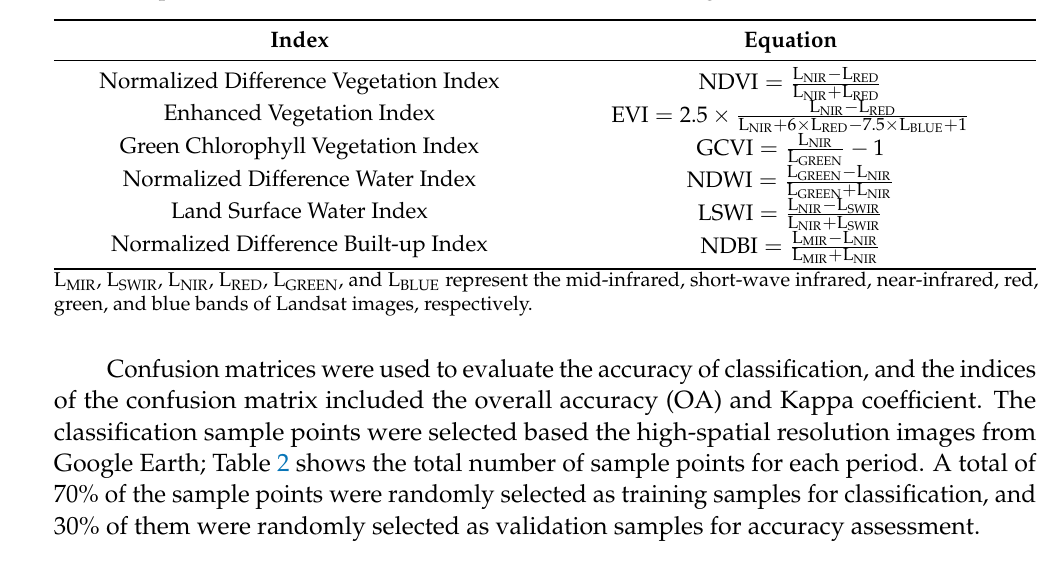
Table 1. Equations of index features used in the Random Forest algorithm.